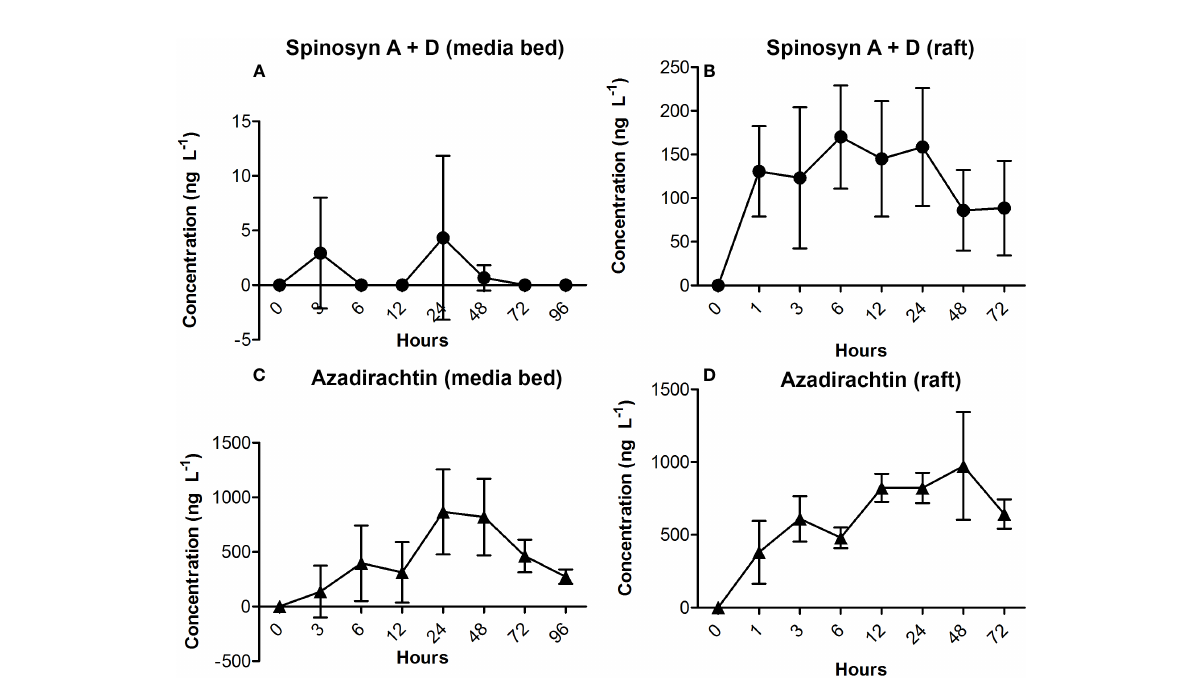
FIGURE 2 Aqueous concentrations of two insecticides in relation to time points at two different systems for growing basil in hydroponics: (A) concentrations of spinosyn A + spinosyn D at media bed system during 96h; (B) concentration of spinosyn A + spinosyn D at fl oating raft system during 96h; (C) concentration of azadirachtin at media bed system during 96h; (D) concentration of azadirachtin at fl oating raft system during